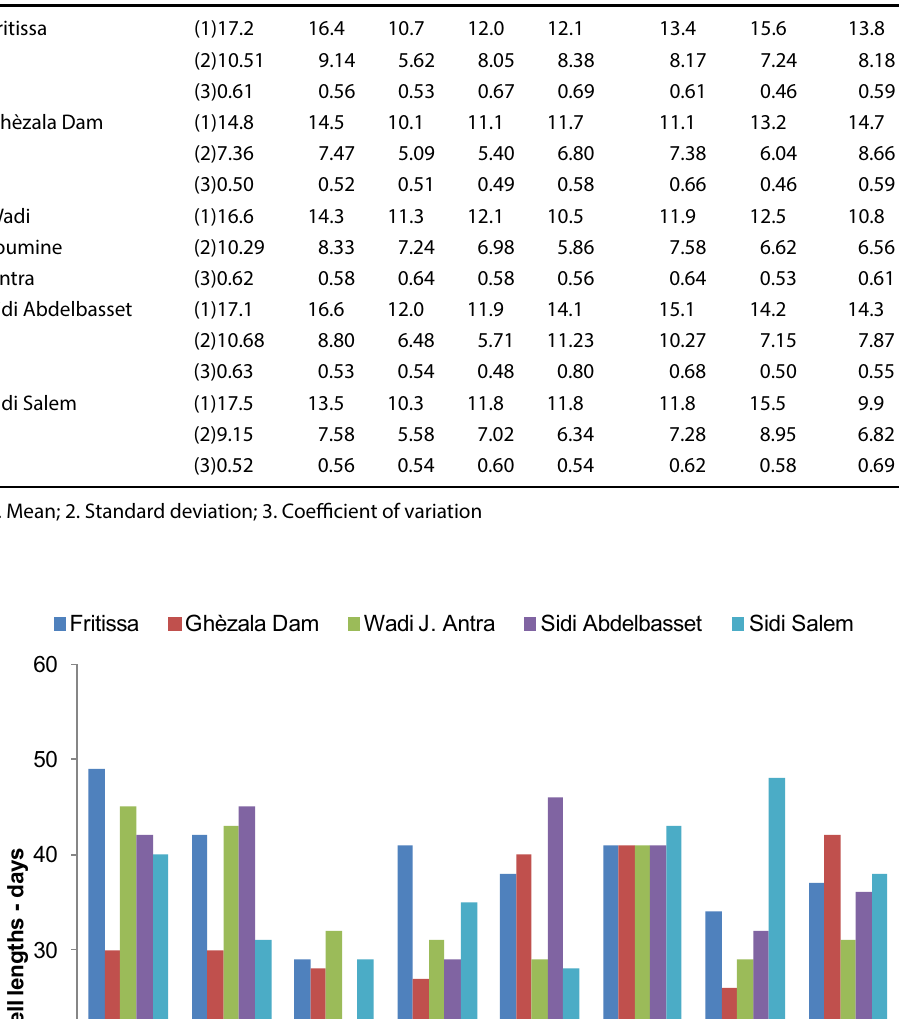
Table 6 Length of maximum monthly dry spell within the rainy season (Ichkeul lake basin)